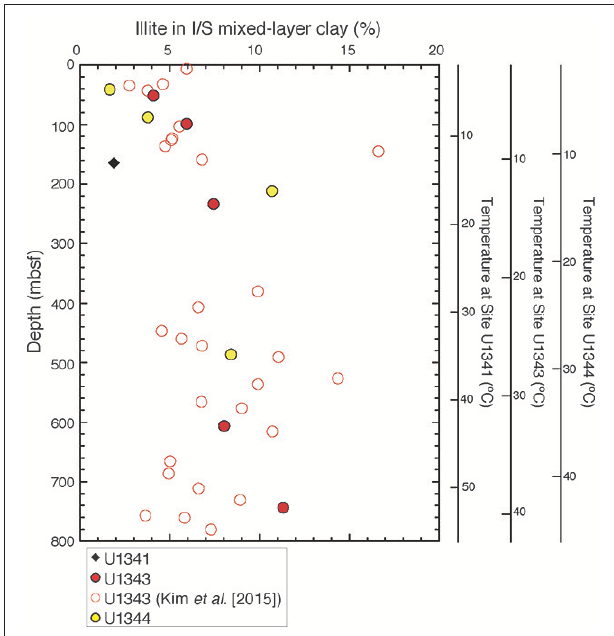
FIGURE 7 | Vertical profile of illite content in the I/S mixed layer at Sites U1341, U1343, and U1344.